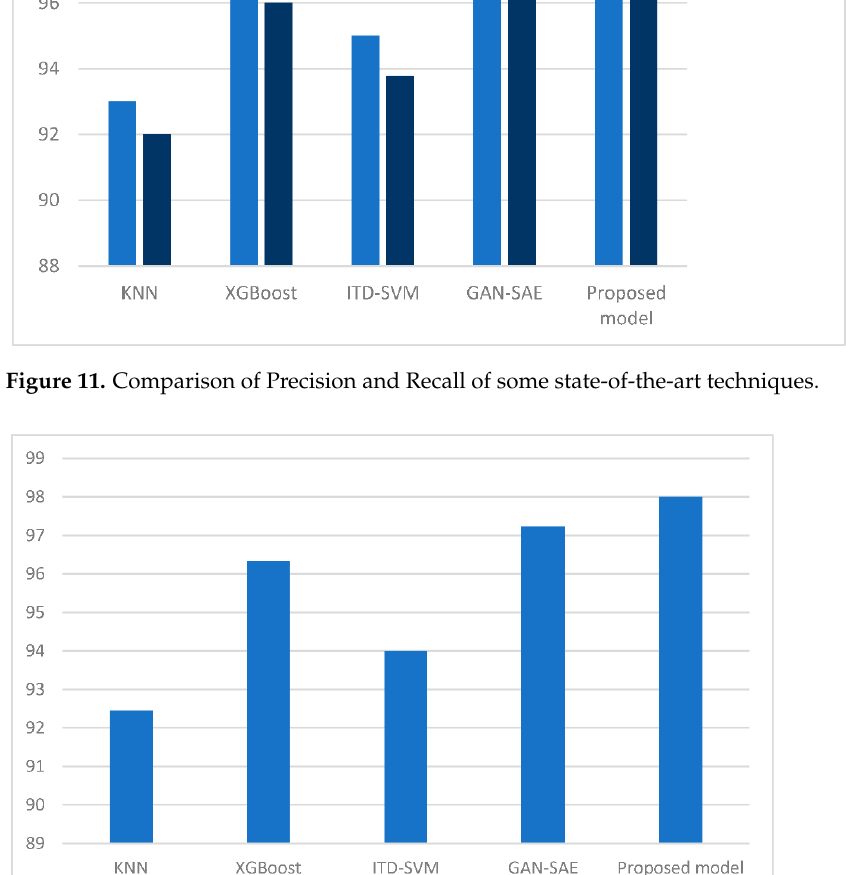
Figure 12. Comparison of F1-Score of some state-of-the-art techniques.